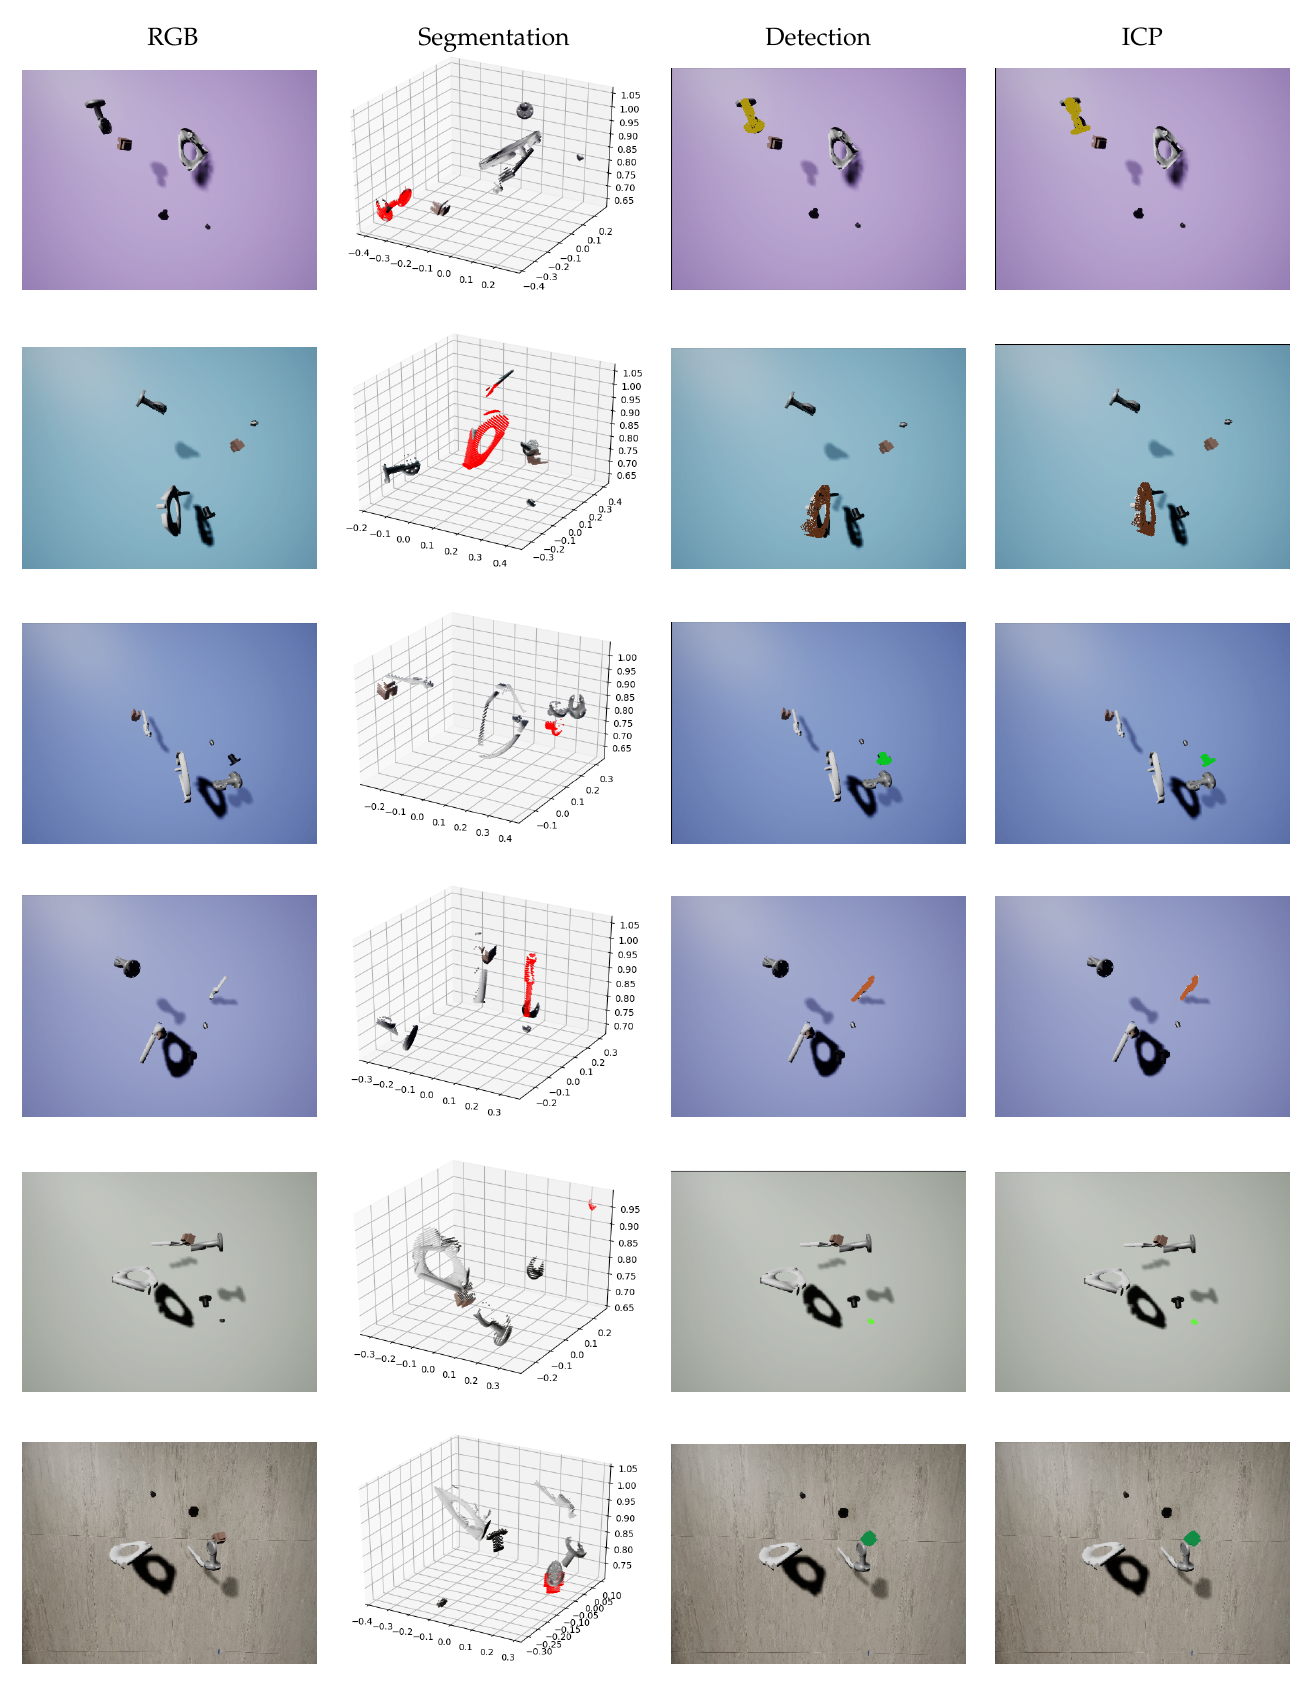
Figure 10. Detection results of the synthetic data. Each row corresponds to an object from Object 1 to Object